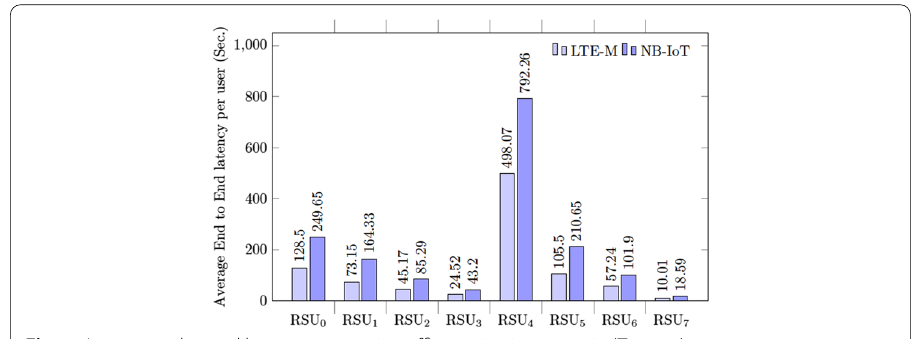
Fig. 5 Average end to end latency per user in traffic monitoring scenario (Toronto)